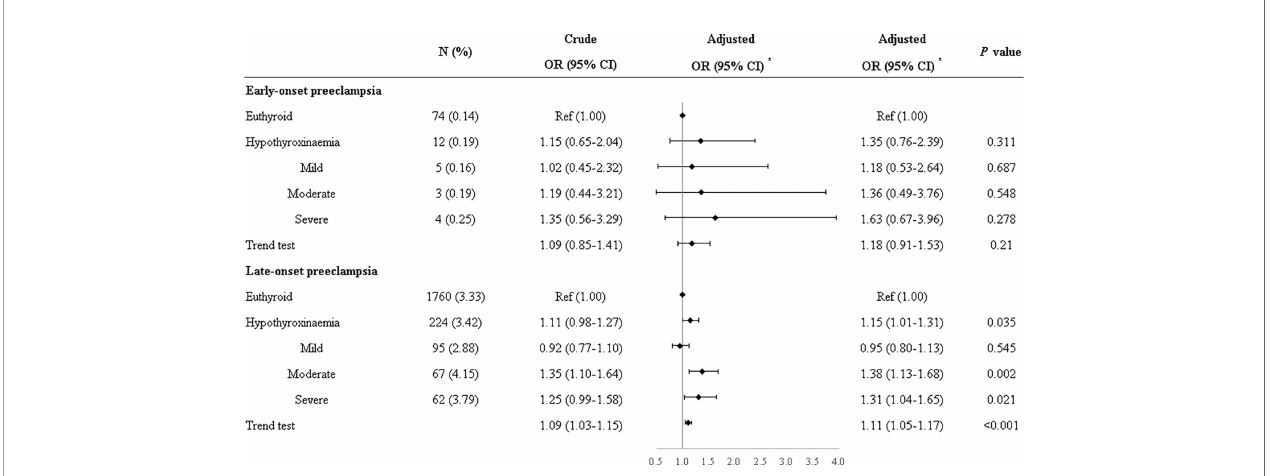
FIGURE 4 | Associations of hypothyroxinemia and risk of early-onset preeclampsia – eclampsia and late-onset preeclampsia – eclampsia. *Adjusted for parity, age, prepregnancy BMI, fetus sex, residence of origin, serum ferritin, thyrotropin level, and TPOAb status.